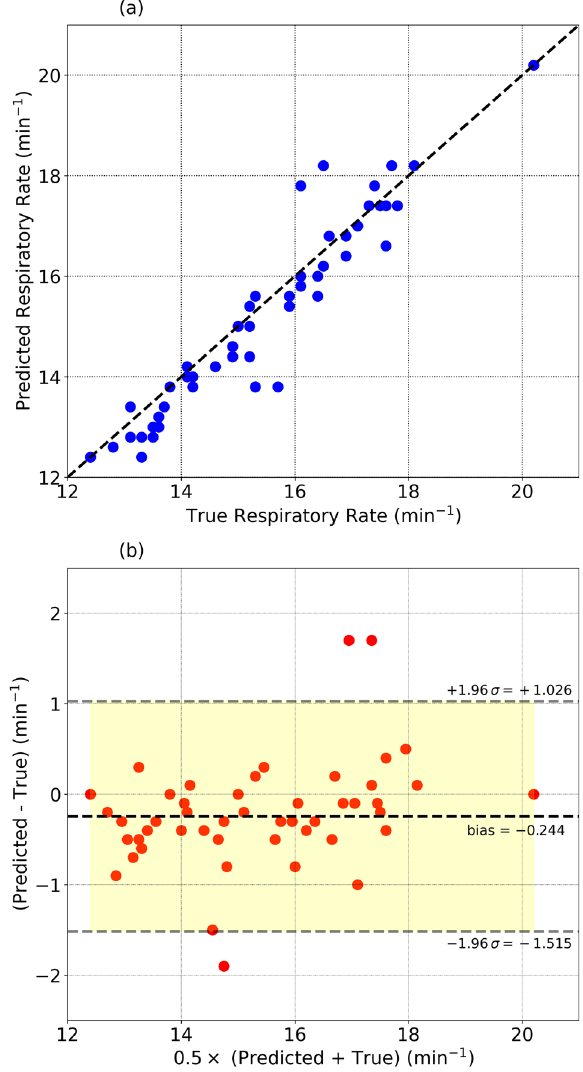
Fig. 8 Comparison with ground truth measurements. a Respira- tory rate estimated from the heart beat interval time series data compared to ground truth measurements. b shows the Bland- Altman plot comparing the true and predicted values. The bias (mean of predicted value – true value) is − 0.24 min − 1 ( − 1.67%). The RMS error = 0.65 min − 1 and the mean absolute error = 0.46 min − 1 (3.0%). The 95% region is shown in